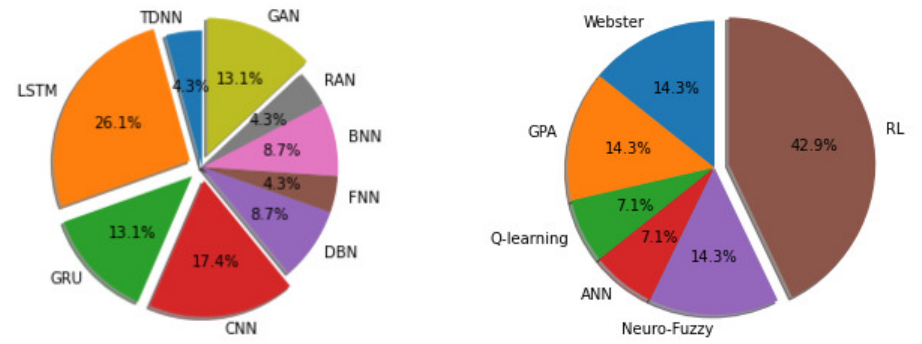
Figure 5. Comparisons among different methods in terms of occurrence between the years 2019 and 2021: the graph on the left is traffic state prediction, and the one on the right is intersection traffic signal